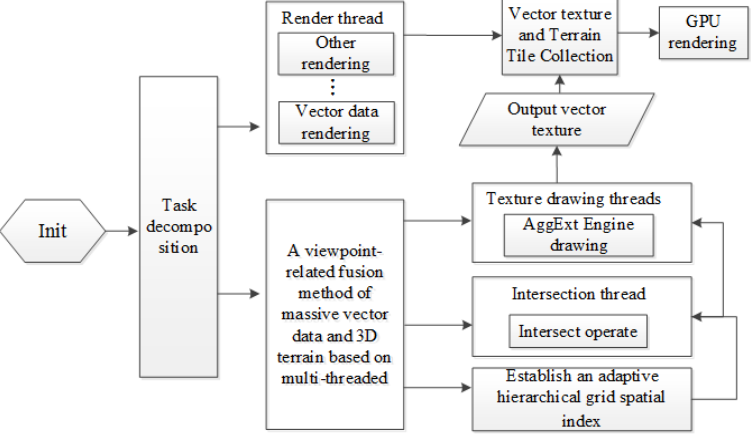
Figure 3. The multi-threaded viewpoint-related fusion